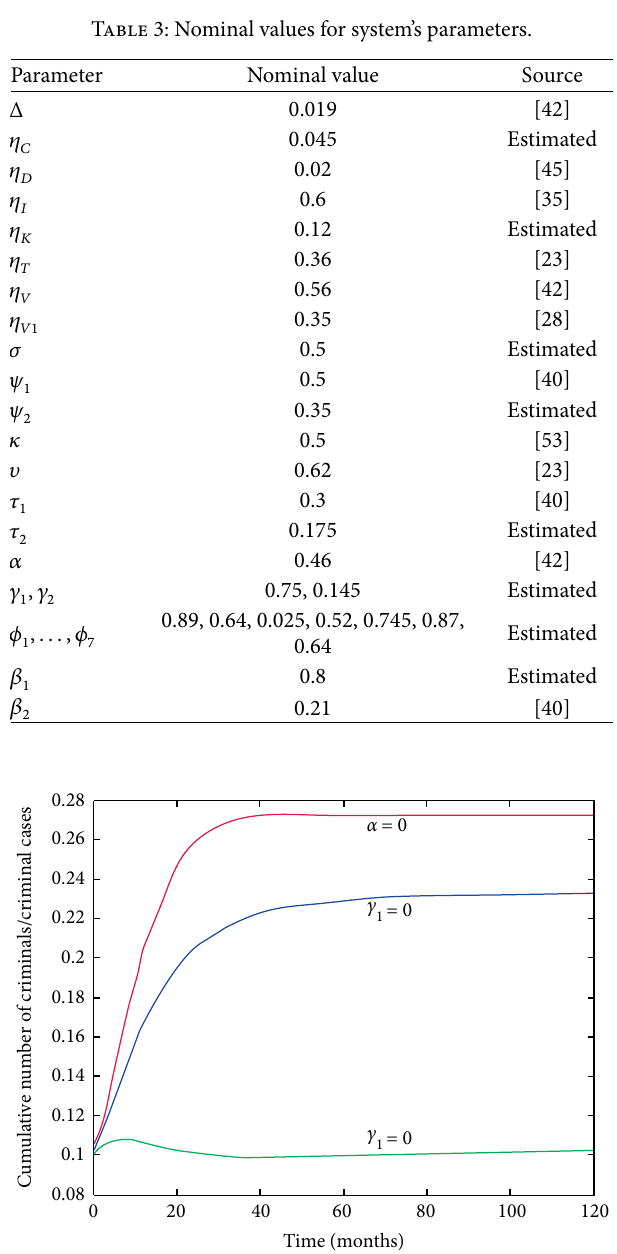
Figure 4: Simulation of model (4) showing the cumulative number ) as a function of time for the of new crimes/criminals ( 𝑆 𝐸 + 𝐶 + 𝐶 𝑅 and changing between zero and their respective values of 𝛼,𝛾 1 , 𝛾 2 values in Table 3. Other parameter values used are as in